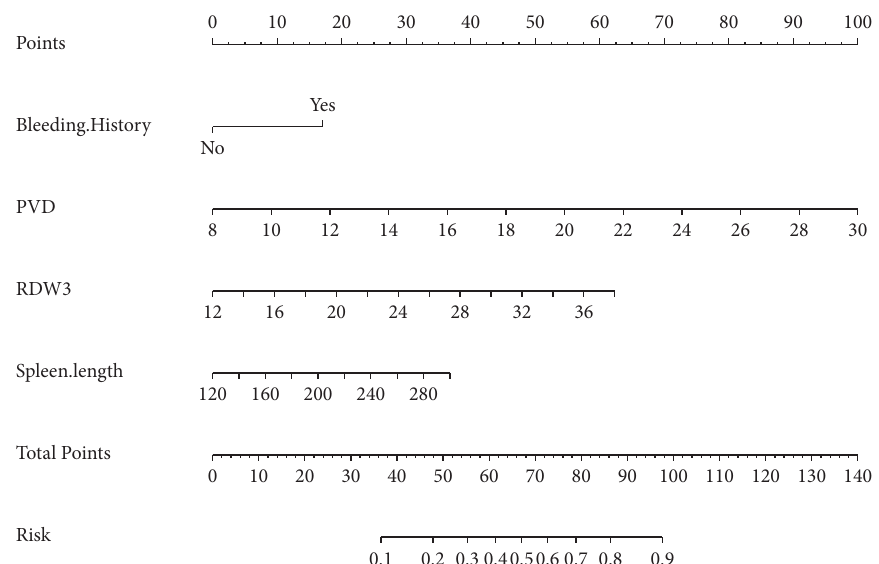
Figure 3: Nomogram based on portal vein diameter, history of bleeding, spleen length, and red blood cell distribution width on post- operative day 3.